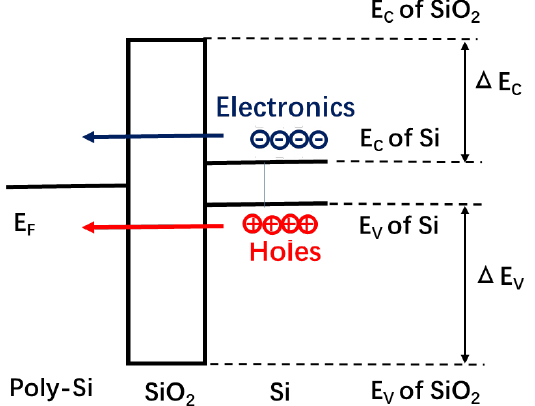
Figure 3. Band diagram of the poly-Si / SiO 2 / Si gate stack.